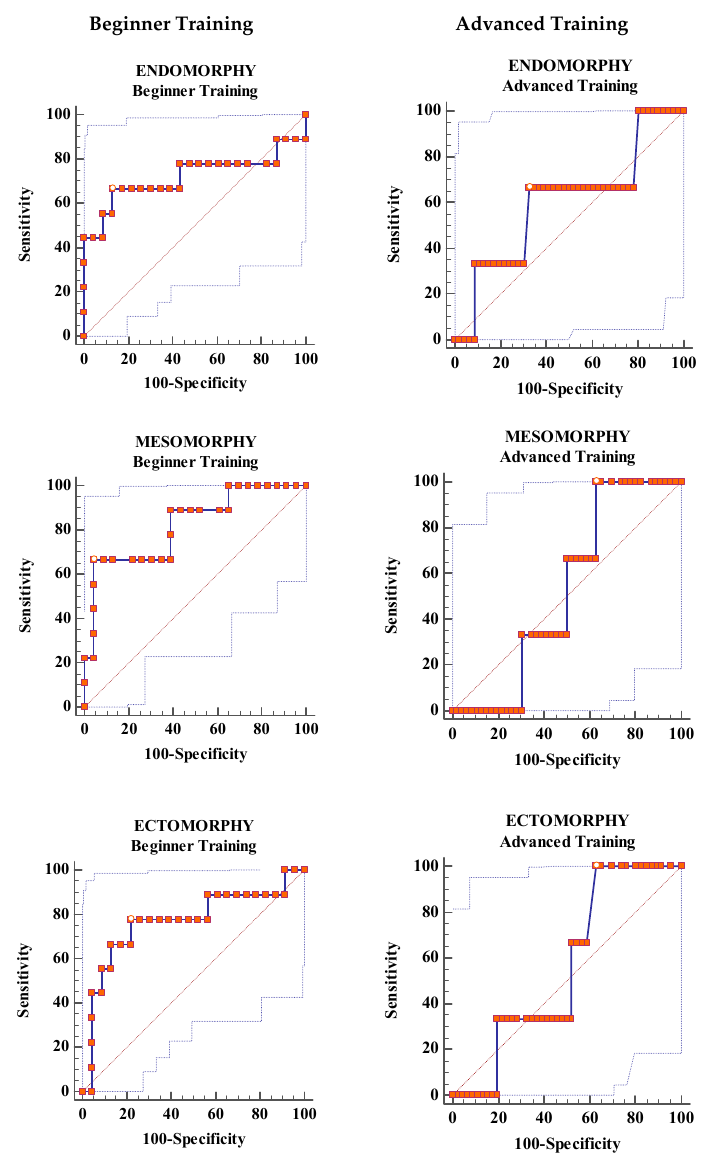
Figure 1. Receiver Operating Characteristics (ROC) curve analysis showing the area under the curve for the prediction of disordered eating attitudes using the Eating Attitudes Test-26 (EAT-26) total score. Table 4. Characteristics of the ROC curves for somatotype components in the beginner training and advanced training groups Beginner Training Advanced Training Endo Meso